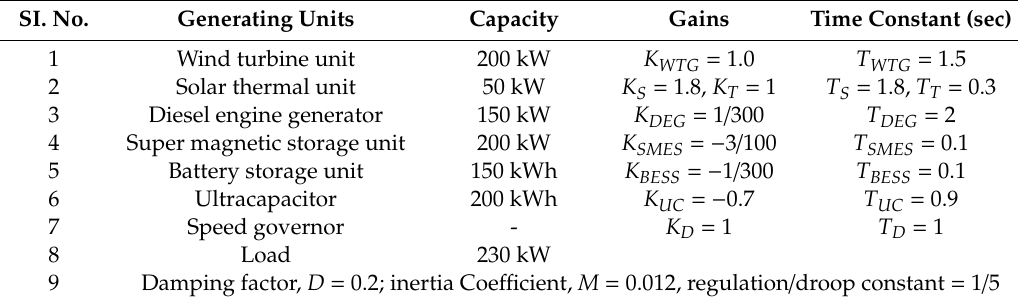
Table 1. Nomenclature with the capacity of the considered system parameters. SI.